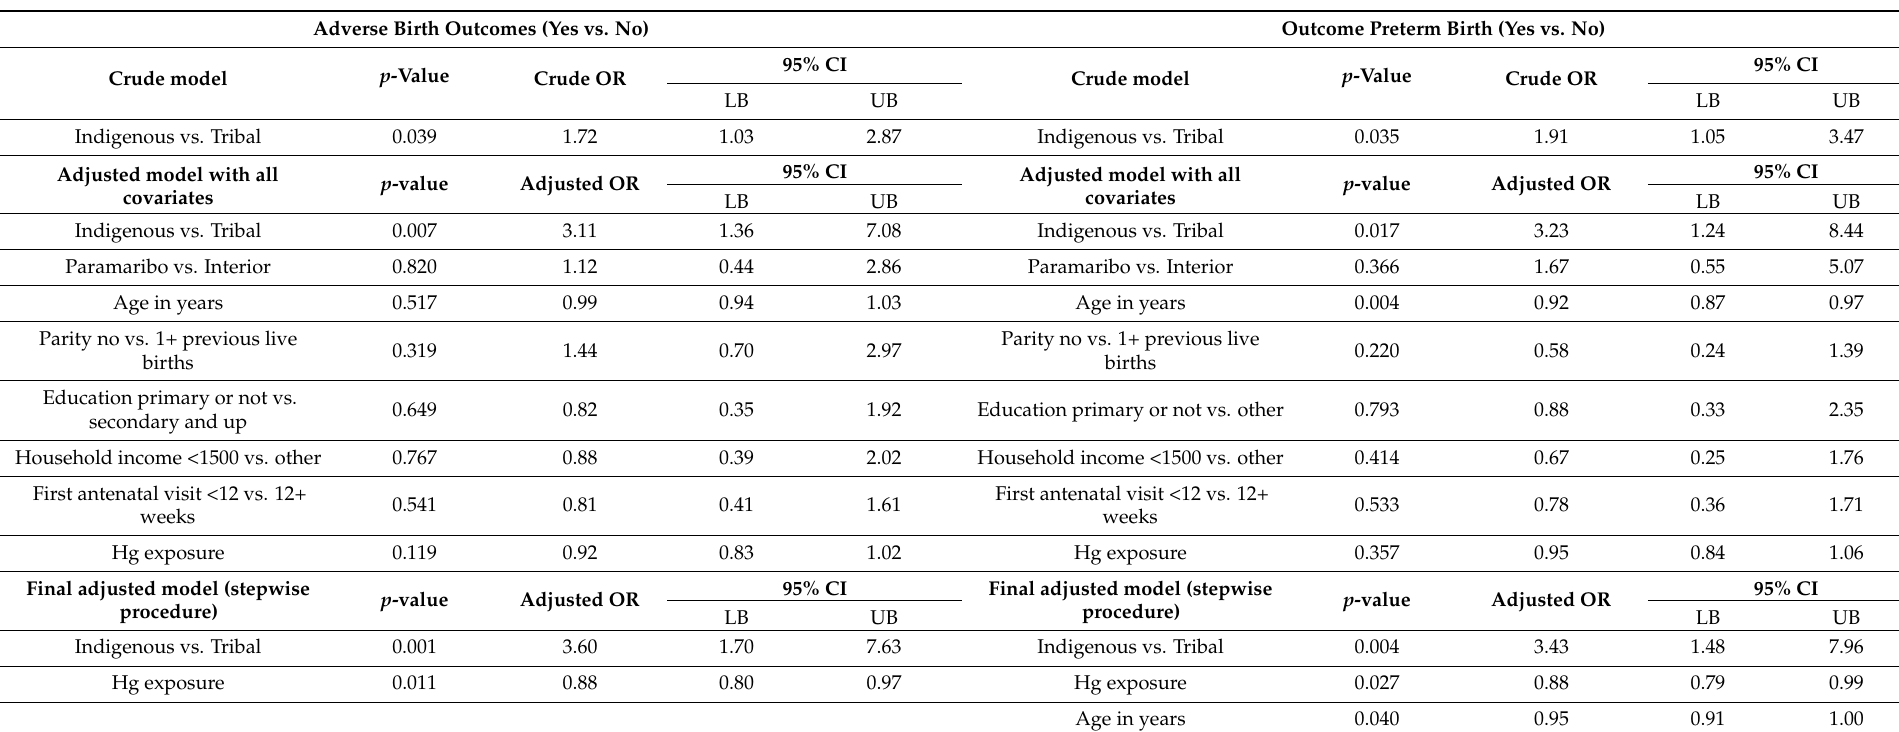
Table 4. Crude and adjusted odds ratios (OR) with 95% confidence intervals (95% CI) for adverse birth outcomes and for preterm